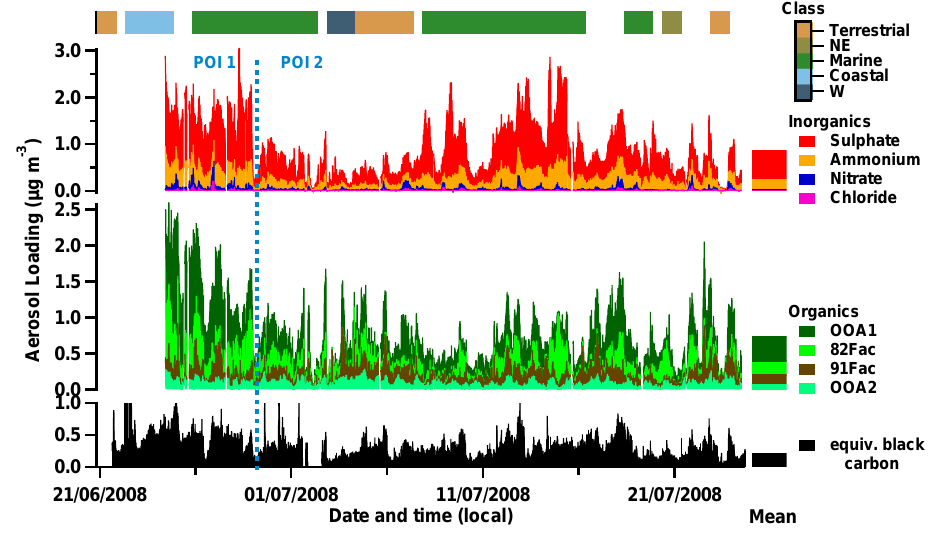
Fig. 10. Stacked time series of total sub-micron non-refractory aerosol split by composition (see Sect. 2.1) for OP3-III. The inorganics and organics are shown on separate axes, with the organics split into their constituent PMF factors. The split point between Period Of Interest (POI) One and Two is marked with a dashed blue line (see Sect. 3.6). The campaign mean aerosol loadings are shown as stacked bars to the right of the time series. Colour of bar at top indicates class of air mass influencing site (see Sect. 2). No bar indicates unclassified (changeable) air mass. Table 3. Comparison of sub-micron non-refractory aerosol loadings (µgm − 3 ) from different tropical campaigns. Bornean and Amazo- nian (Chen et al., 2009) measurements are campaign averages of ground site intensives. West African measurements are averages of low altitude data over several flights, screened to remove (local) biomass burning and anthropogenic influence (Capes et al., 2008,